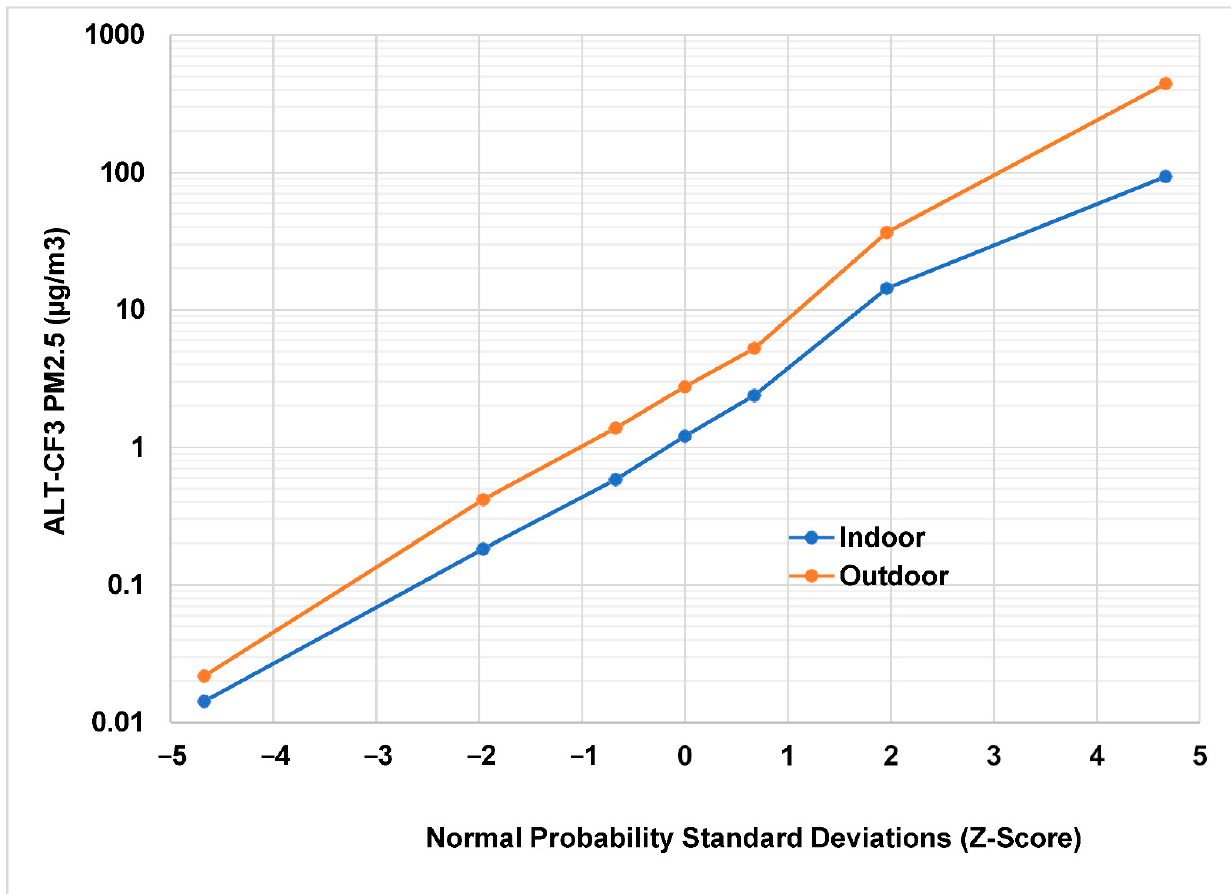
Figure 1. Indoor and outdoor PM 2.5 concentrations (N = 353,256) over 18 months using the ALT-CF3 algorithm. The three middle points centered on the median at 0 provide the interquartile range (25th and 75th percentiles).